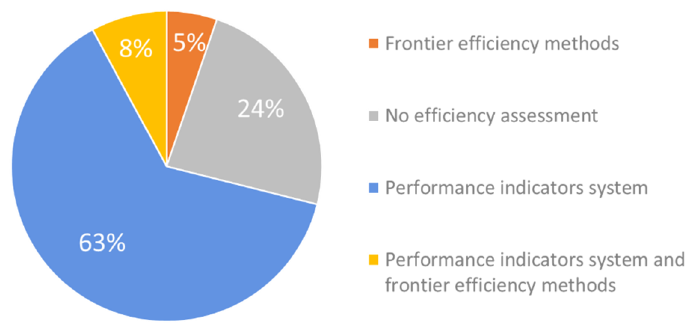
Figure 1. Methods used by water regulators to assess the efficiency of water utilities.